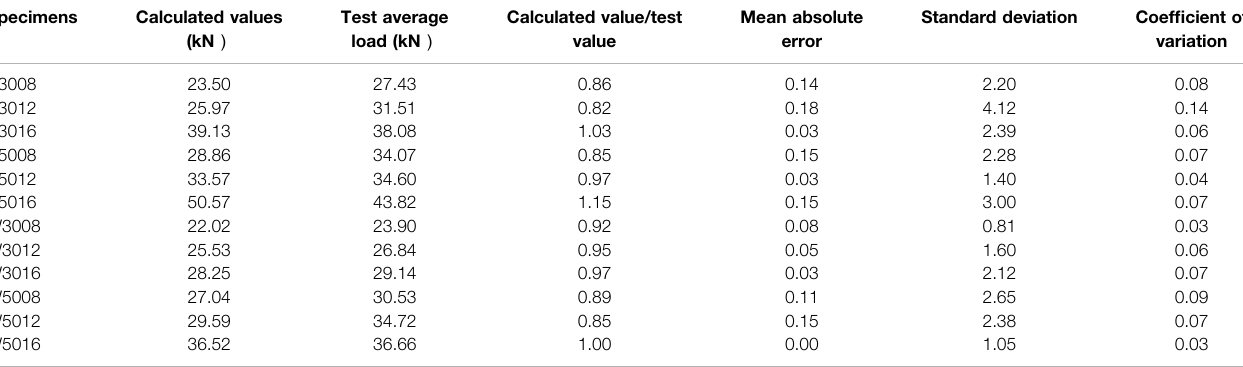
TABLE 6 | Comparison of test and calculated values of the shear capacity. Specimens Calculated values